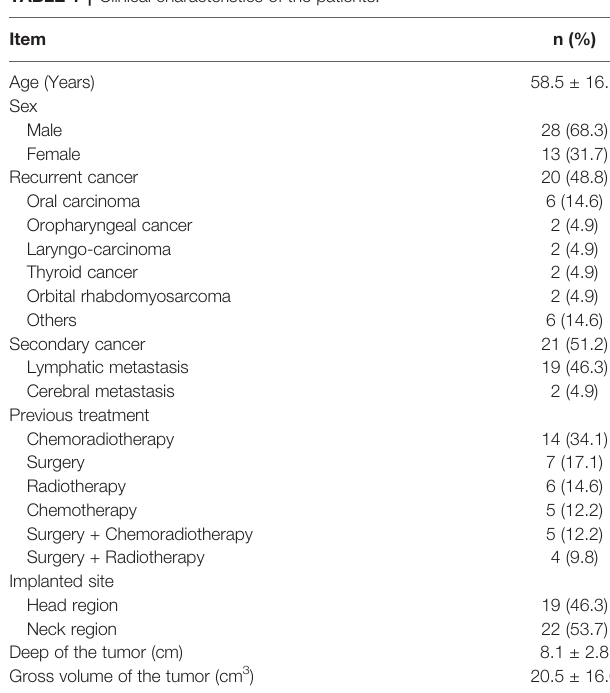
FIGURE 1 | The fl ow chart of the study and measurement of the deviation between planned needle (black) and intraoperative needle (red) after fusing the planned and intraoperative CT images into the same coordinate axis on brachytherapy treatment planning system (BT-TPS): entrance point deviation (short arrow), depth deviation (arrowhead), and angle deviation (long arrow). TABLE 1 | Clinical characteristics of the